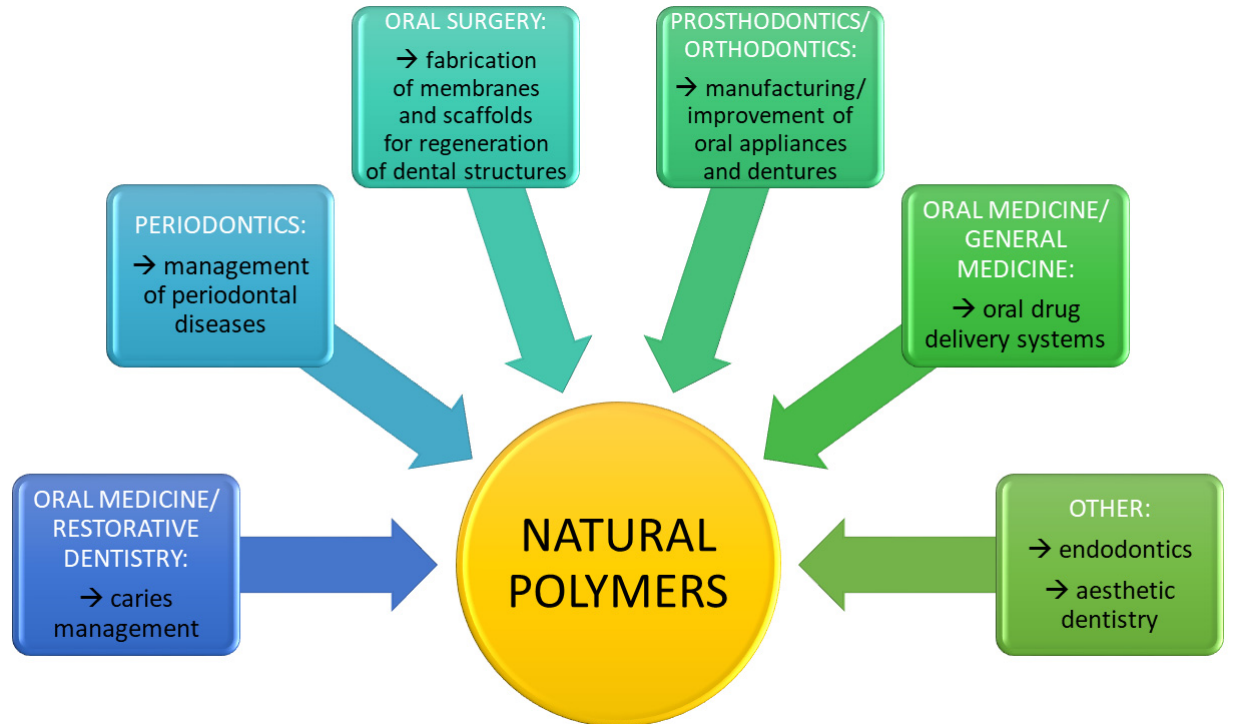
Figure 3. Summary of the application s of natural polymers in different dental specialties .